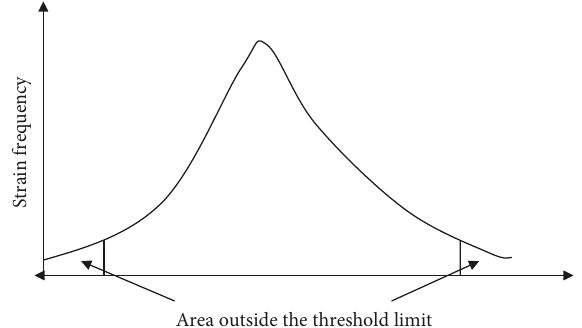
Figure 9: Example of frequency distribution of strain within and outside the threshold